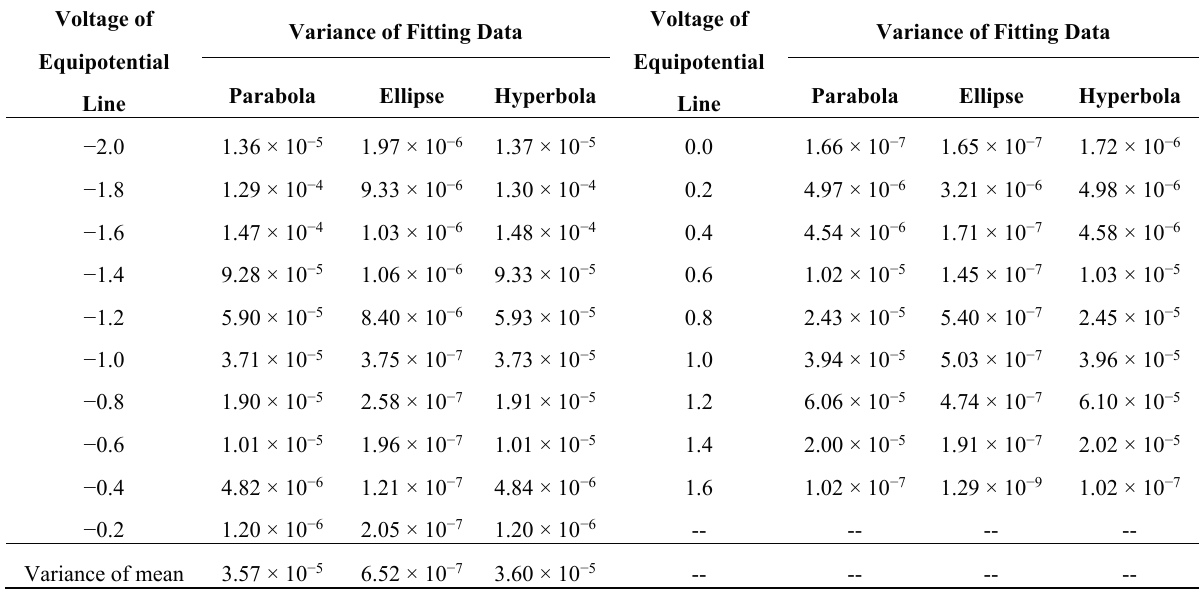
Table 2. Variance of fitting data by different